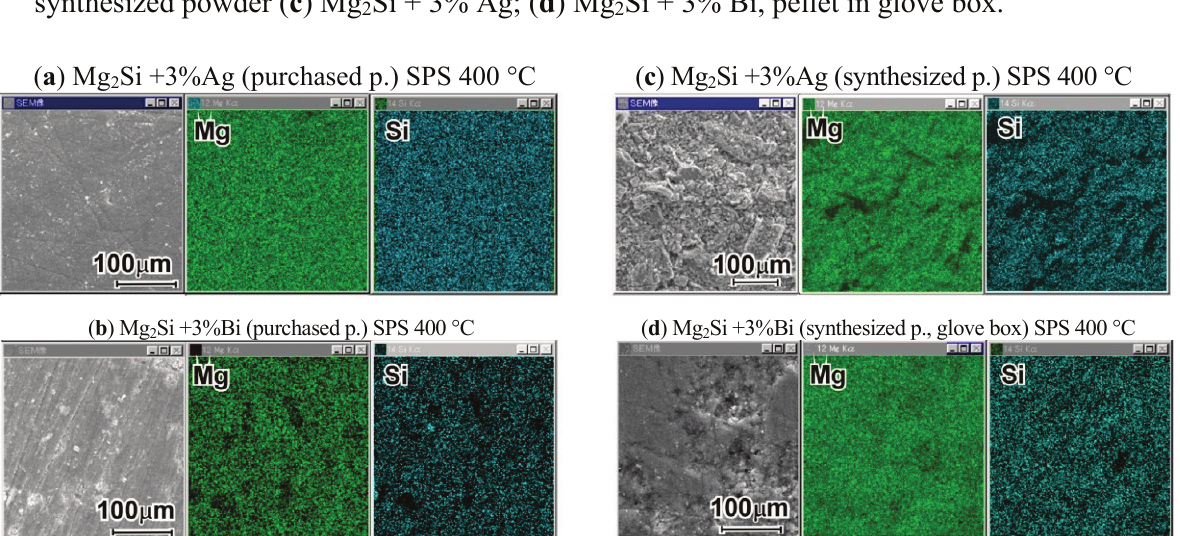
Figure 4. SEM-EDX characterization of the bulk specimen produced from ( a , b ) purchased powder ( a ) Mg Si + 3% Ag; ( b ) Mg Si + 3% Bi, pellet in glove box and from ( c , d ) 2 2 synthesized powder ( c ) Mg Si + 3% Ag; ( d ) Mg Si + 3% Bi, pellet in glove box. 2 2